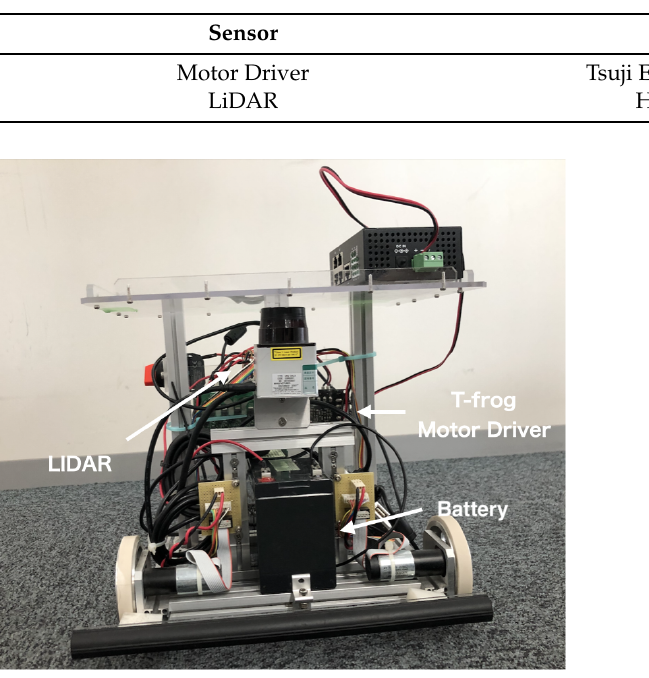
Table 5. Sensor details.